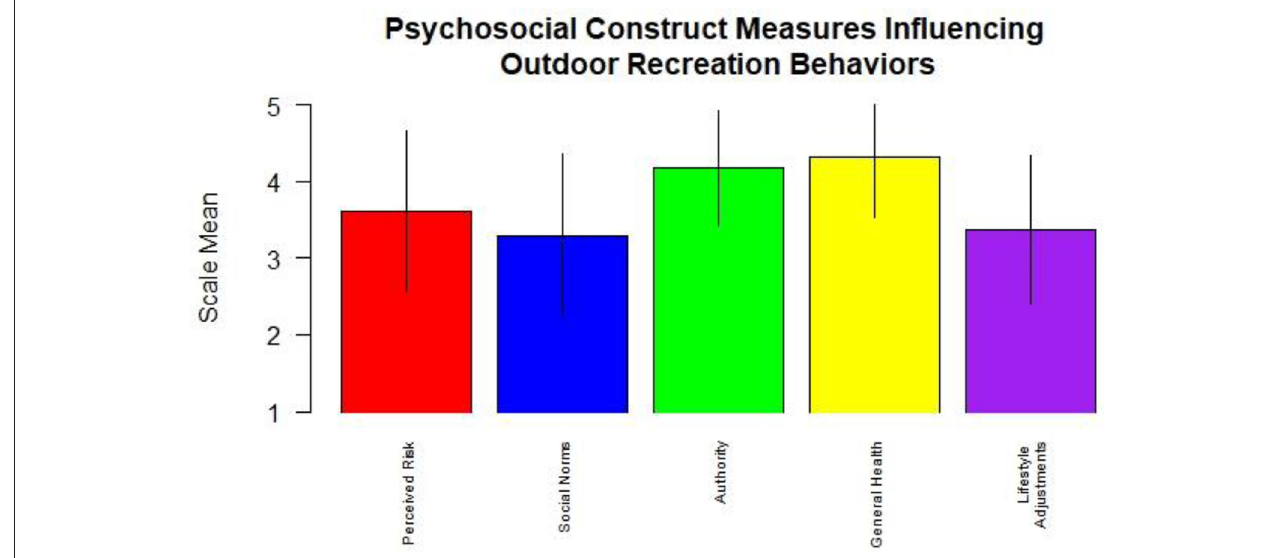
FIGURE 2 | Importance ratings for each psychosocial factor influencing outdoor recreation behavior analyzed through a repeated measures ANOVA [ F (3.16,3082.14) = 309.50, p -value < 0.001]; all means are significantly different from each other ( p < 0.001) excluding Lifestyle Adjustments and Social Norms ( p = 0.648); error bars represent the standard deviation for each psychosocial construct.